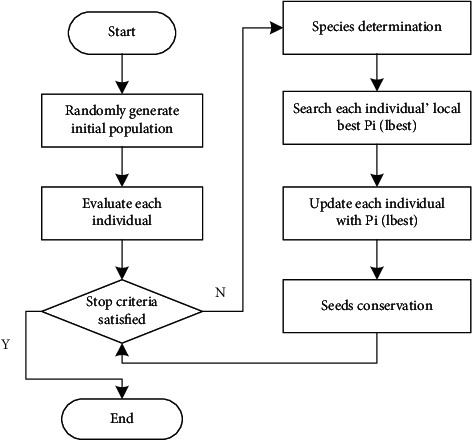
Flowchart of sslPSO.